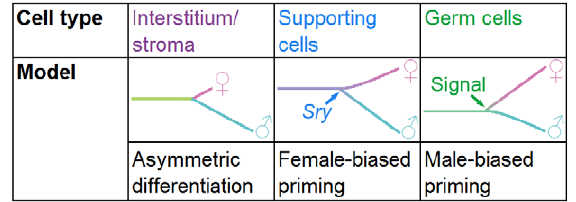
Figure 7. Models of differentiation for the different gonadal lineages. The interstitial/stromal cells differentiate asymmetrically over the time period examined, as we detected few genes specific to the XX stroma by E13.5, whereas, the XY interstitial population acquired a larger set of lineage-specific genes. Supporting cells are primed with a female bias. The natural progression of the primed state may be to adopt the female differentiated state, but in the presence of Sry the cells repress the female program and adopt the male fate. Conversely, germ cells are primed with a male bias. An extrinsic signal may be required from the mesonephros to induce the adoption of the female fate; otherwise, germ cells adopt the male fate.